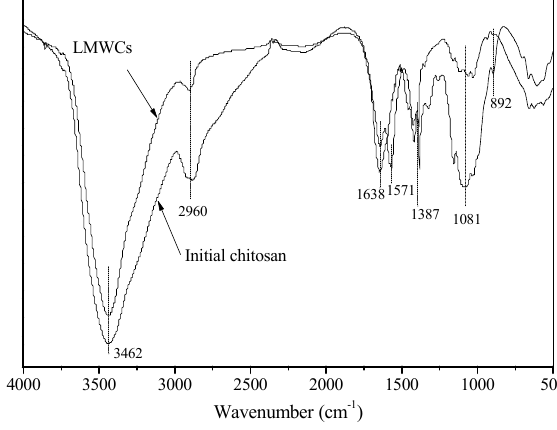
Figure 4. FTIR spectra of the initial chitosan and low molecular weight chitosan (LMWC) samples.